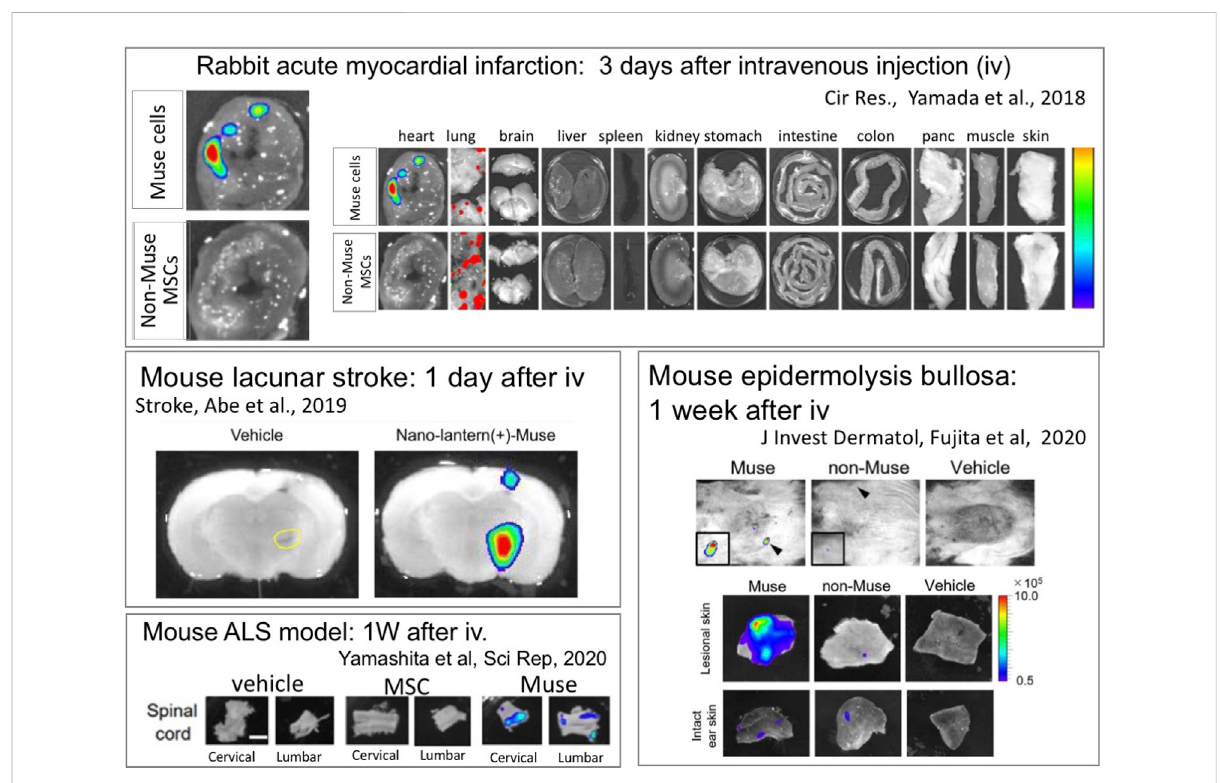
Intravenously administered Muse cells selectively home to the damaged site. Nano-lantern – or Akaluc-labeled human Muse cells were intravenously injected into a rabbit model of acute myocardial infarction (3 days after) (Yamada et al., 2018), a mouse models of lacunar